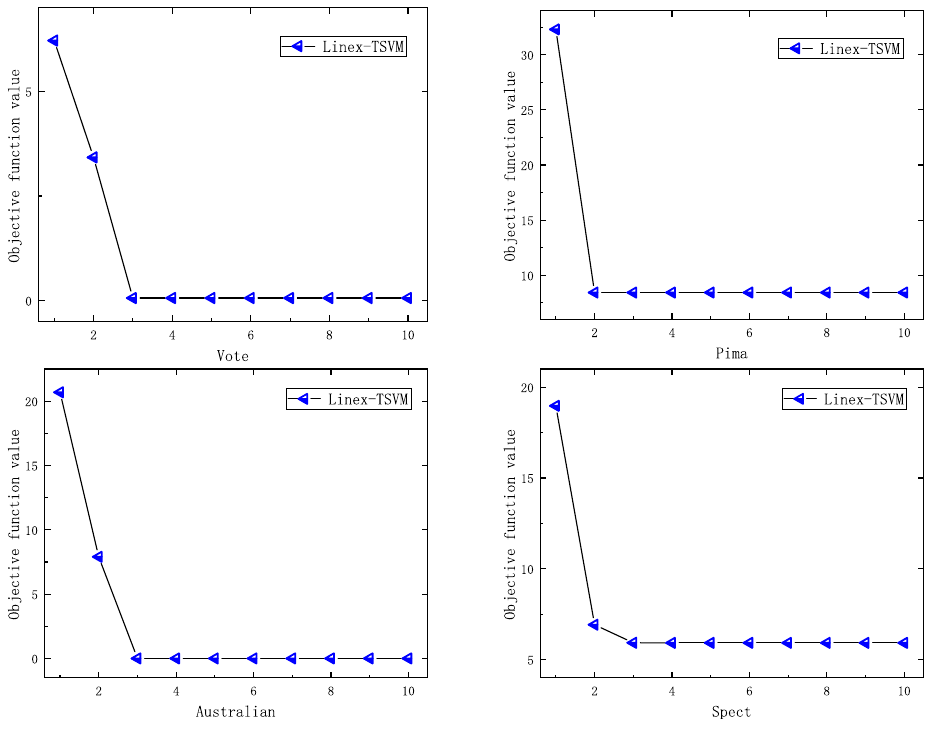
Figure 6. Convergence rate of